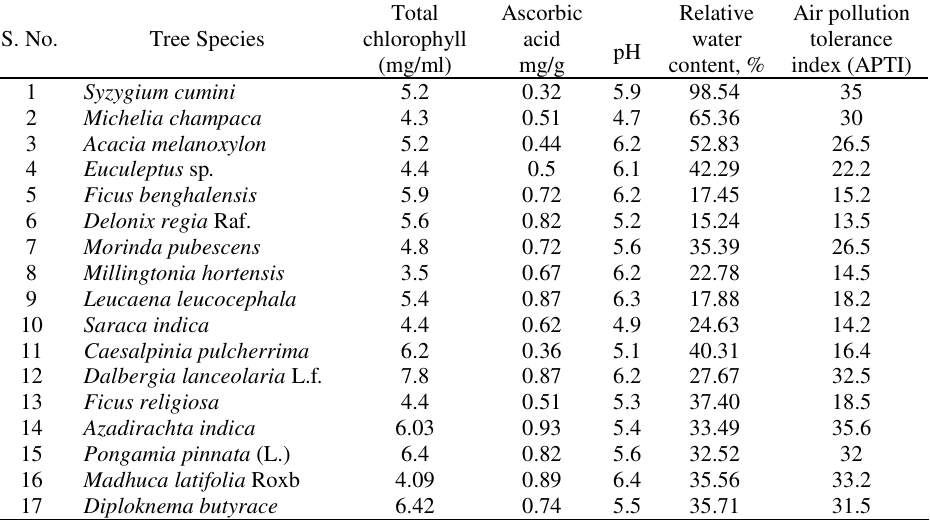
Table 5. Air pollution tolerance index (APTI) of tree species from Bommasandra industrial area of south Bengaluru S.